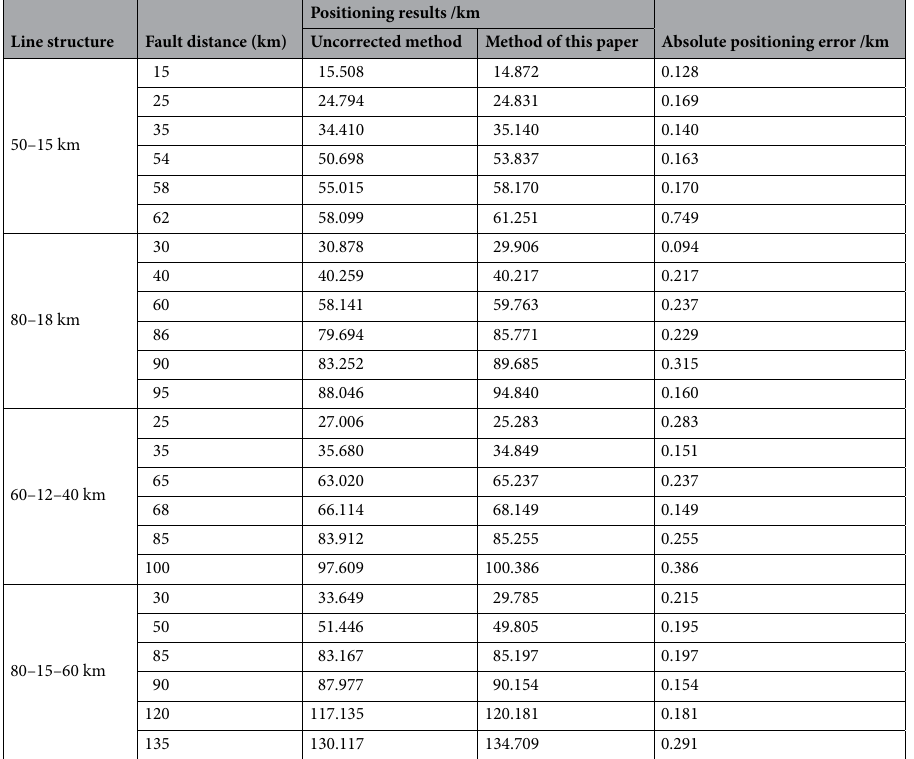
Table 8. Location results under different line structures and fault